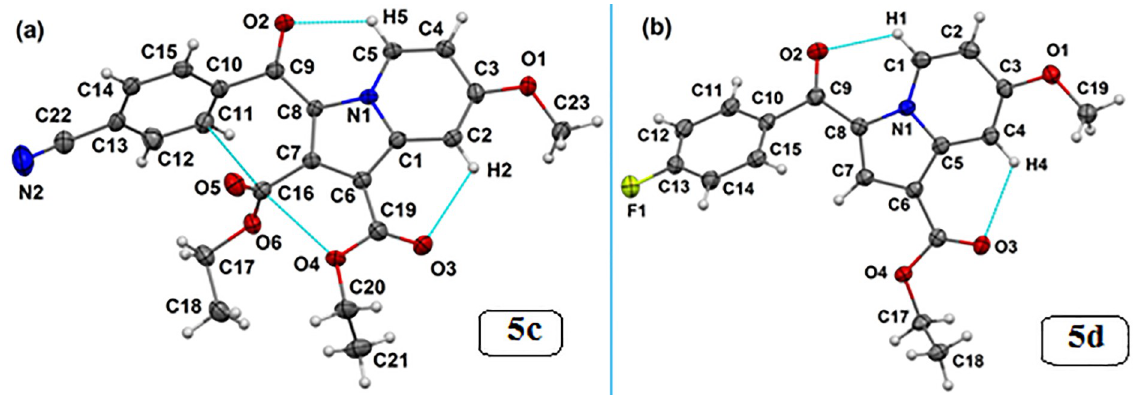
Fig 6. Thermal ellipsoidal plots drawn at the 50% probability level for the crystal structures of (a) 5c (second symmetry independent molecule has been omitted for clarity, Z’ = 2) and (b) 5d. Dotted lines indicate intramolecular interactions.